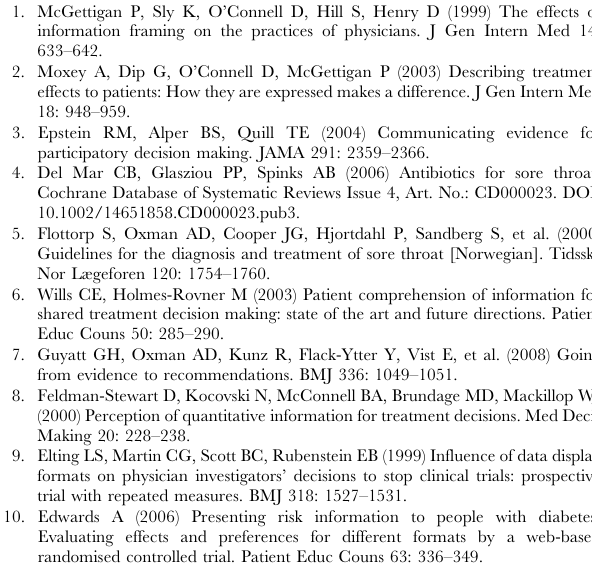
Figure S1 CONSORT flow